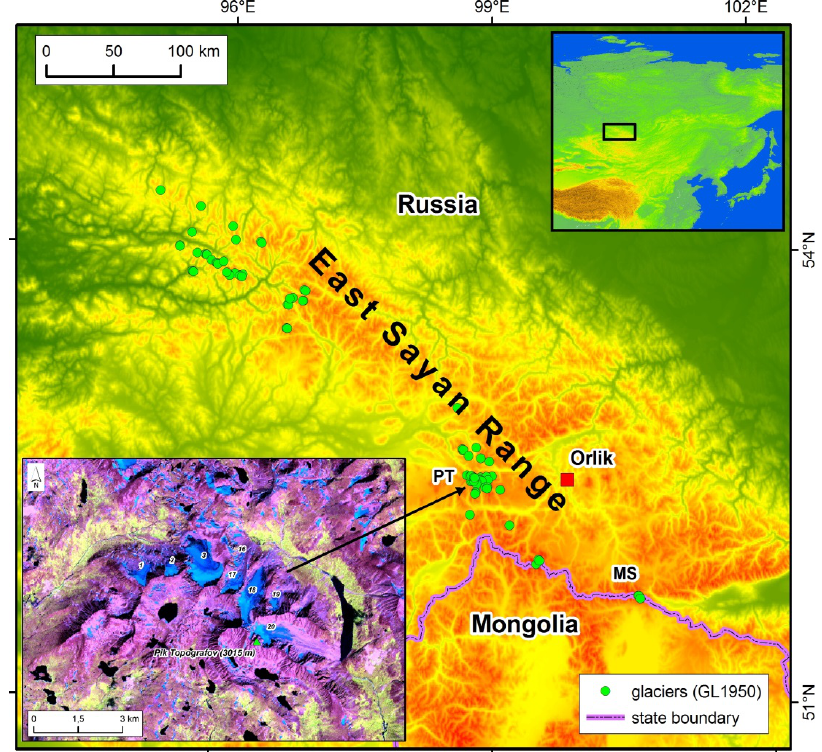
Figure 1. Study area (East Sayan Range) with glaciers and used Landsat scenes. Referenced glaciers (of the GI1950) are depicted by non-scale symbols. SRTM (~90 m resolution) is used as a background. Upper right inset shows the location of the East Sayan Range in Asia. MS is Munku-Sardyk, and PT is Pik Topografov. Lower left inset shows the Pik Topografov massif and studied glaciers (Landsat ETM+ image of 9 August 2001 is as background). The glacier numbers correspond to those in the GI1950 [7].